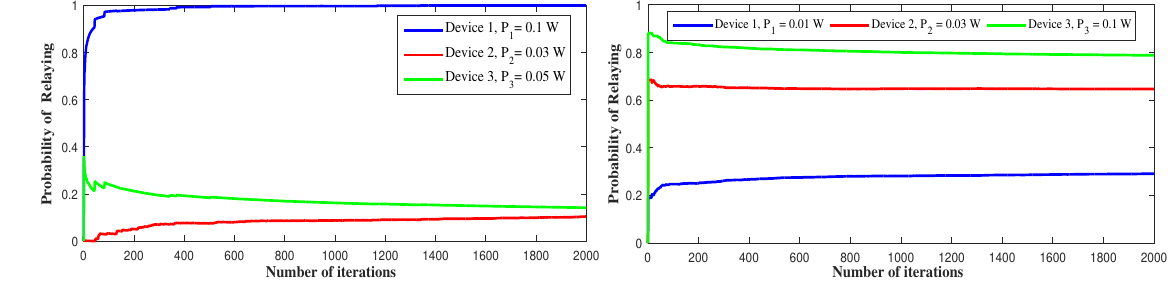
Figure 11. Long-term relaying probability under different transmit power schemes. Figure 12 represents the long-term behavior of the devices with respect to γ th . Having